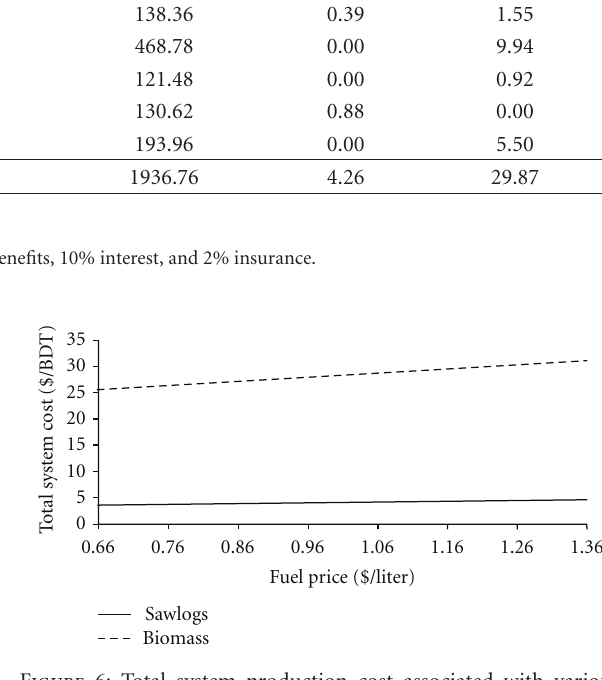
Figure 6: Total system production cost associated with various diesel fuel